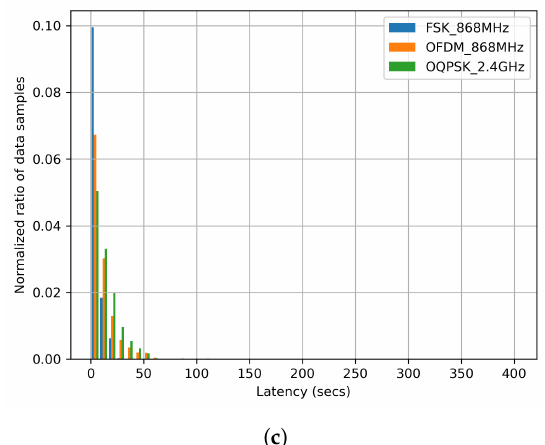
Figure 8. End-to-end latency in the network recorded over the entire 90 min experiments. The longer the PHY range, the lower the latency. ( a ) Time serie; ( b ) Cumulative Density Function (CDF); ( c ) Probability Density Function